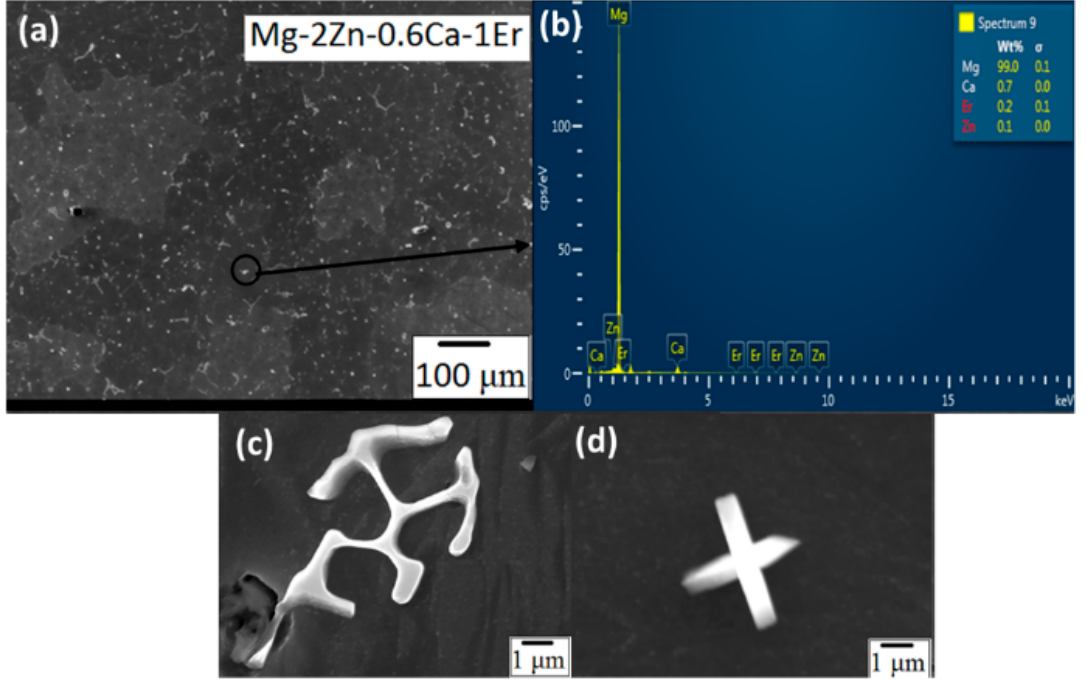
Figure 3. ( a ) SEM image, ( b ) EDS-analysis, ( c ) and ( d ) intermetallic phase constituents of as- disintegrated melt deposited (DMDed) Mg-2Zn-0.6Ca-1Er.